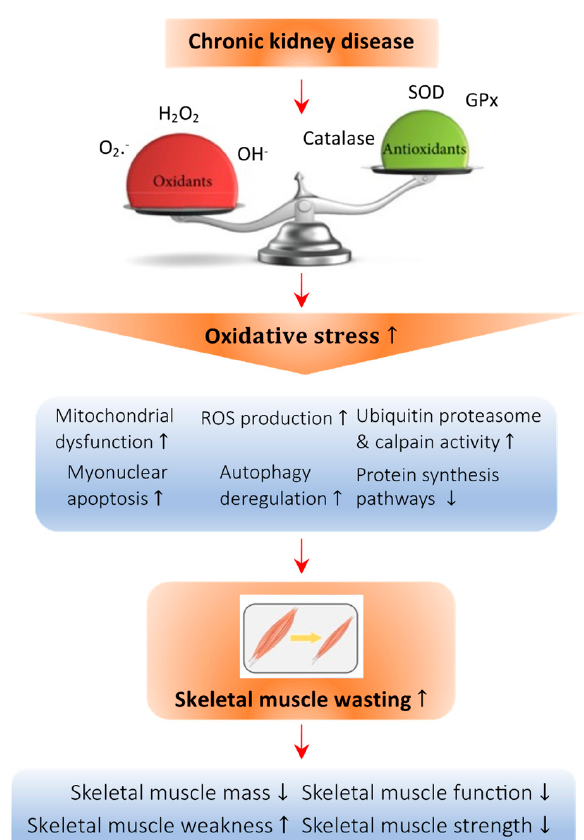
Figure 1. Abnormal redox signaling in CKD-associated muscle wasting. Regulation of the redox state is important in muscle cells to maintain homeostasis. Deficiency of vitamin D leads to an imbalance in the oxidative state, which increases the amount of oxidant species such as O 2 − , H 2 O 2 , and OH − and decreases the presence of antioxidant species such as catalase, superoxide dismutase (SOD), and glutathione peroxidase (GPx). This imbalance causes oxidative damage to the cellular architecture of skeletal muscle cells and is known as oxidative stress. Specifically, oxidative stress can promote mitochondrial dysfunction and the production of ROS, raise the activity of the ubiquitin proteasome system, enhance myonuclear apoptosis and autophagy, and decrease the protein synthesis pathway, all of which lead to skeletal muscle atrophy. Arrow in the figure indicates the pathological development of the abnormal redox signaling in CKD-associated muscle